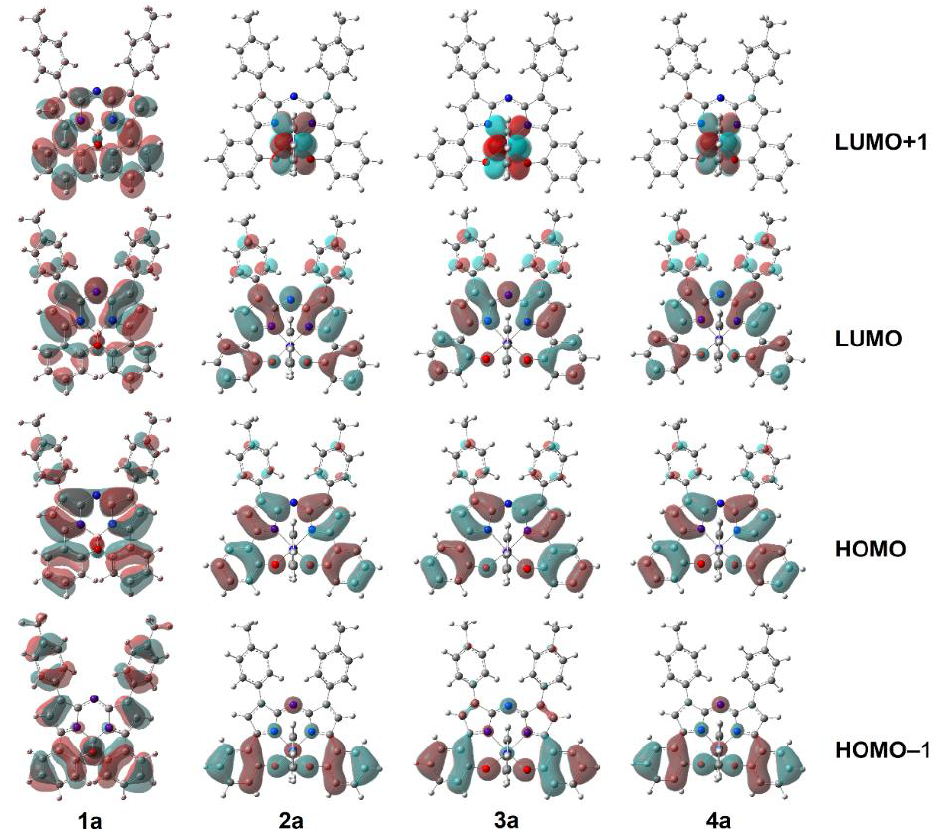
Figure 5. HOMO-1, HOMO, LUMO, and LUMO+1 plots of 1a , 2a , 3a , and 4a . Calculations were performed at the B3LYP/jul-cc-pVDZ level of theory for 1a , 2a , and 3a and the B3LYP/LanL2DZ level of theory for 4a with MeOH as the implicit solvent for all compounds. Table 1. Photophyiscal and computational data for bis(phenolate) aza-DIPYs 1a-b , 2a-b , 3a-b , and 4a-b